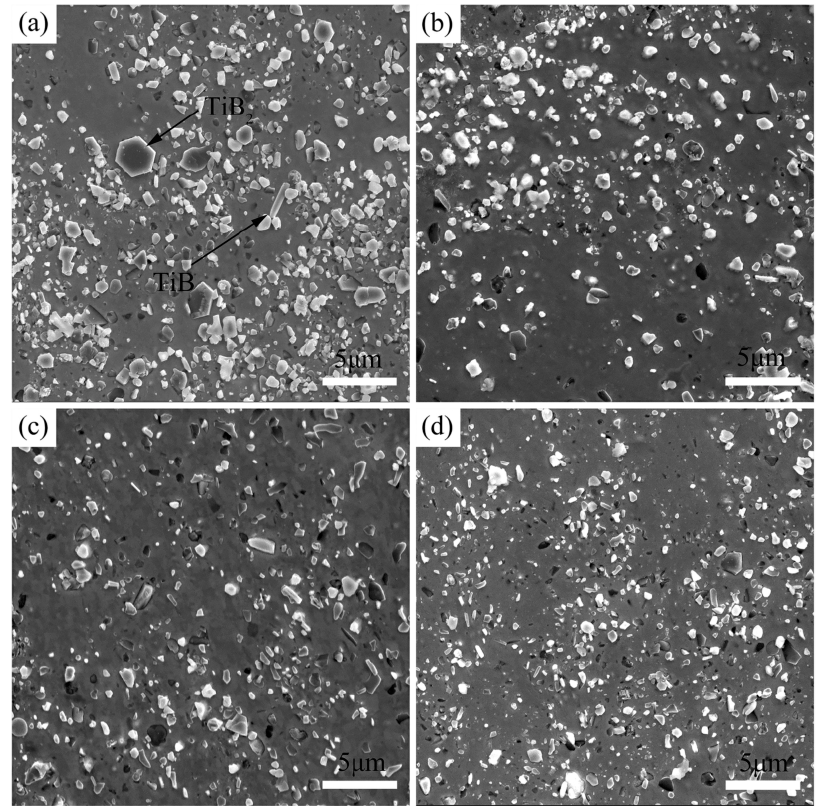
Figure 12. Effects of different rare earths on the microstructures of (TiB 2p + TiB w )/Cu composites: ( a ) without rare earth; ( b ) 0.04 wt.% La; ( c ) 0.04 wt.% Ce; and ( d ) 0.04 wt.% Y [36]. Reprinted/adapted with permission from Ref. [36]. Copyright year 2022,